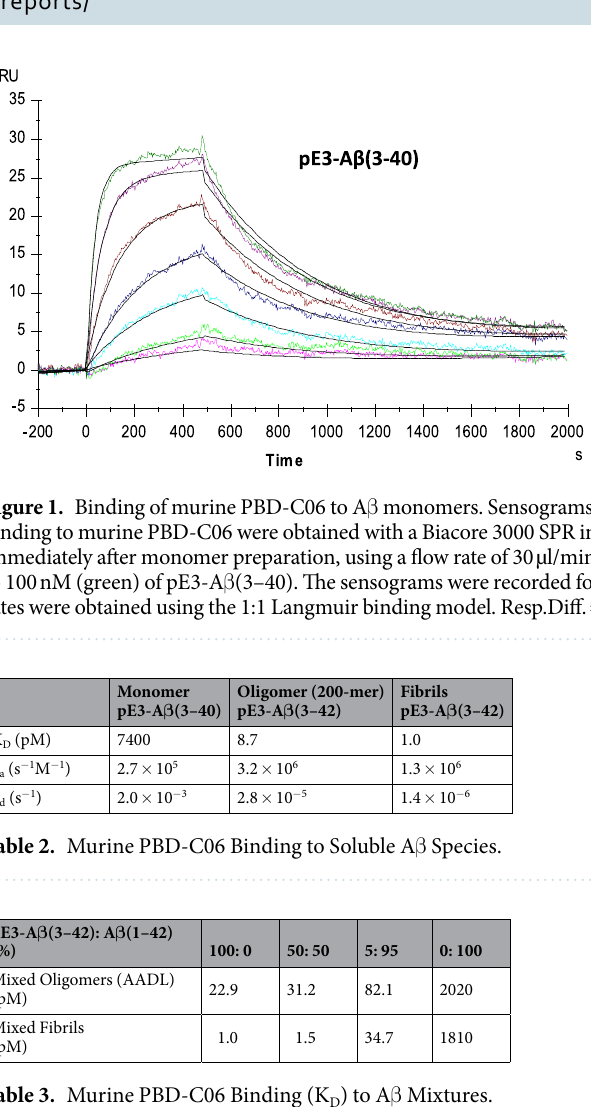
Table 3. Murine PBD-C06 Binding (K D ) to A β